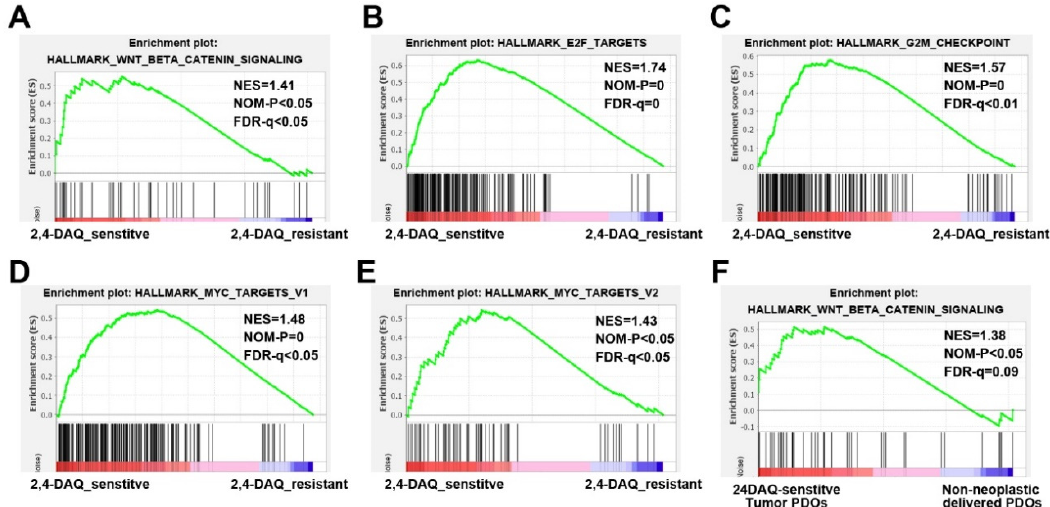
Figure 7. Gene set enrichment analysis (GSEA) of transcriptional profiles in patient-derived organoids . GSEA analysis using hallmark gene sets from the molecular signature database for the transcriptional difference in patient-derived organoids. ( A ) Enrichment plots of genes in the hallmark_Wnt_beta-catenin-signaling; ( B ) hallmark_E2F_targets; ( C ) hallmark_G2M_checkpoint; ( D ) hallmark_MYC targets_V1 and ( E ) hallmark_MYC targets_V2 gene sets showed significant enrichment in 2,4-DAQ-sensitive tumor-derived organoids (ID: 01, 02, 04) versus 2,4-DAQ-resistant tumor-derived organoids (ID: 03, 05, 06). Enrichment plot of genes in ( F ) hallmark_Wnt_beta-catenin- signaling gene sets showed significant enrichment in 2,4-DAQ-sensitive tumor-derived organoids versus 2,4-DAQ-sensitive nonneoplastic lesions-derived organoids. NES—normalized enrichment score; NOM-P—nominal p -value; FDR- q —false discovery rate q -value.